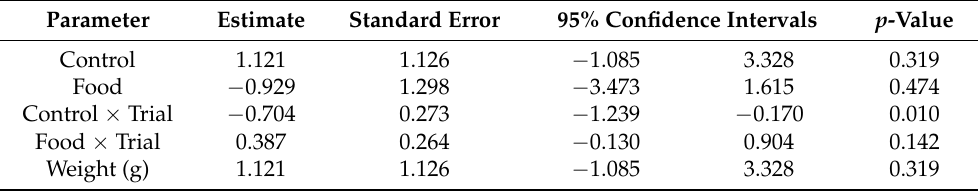
Table 3. Experiment 3 Startle Probability Regression